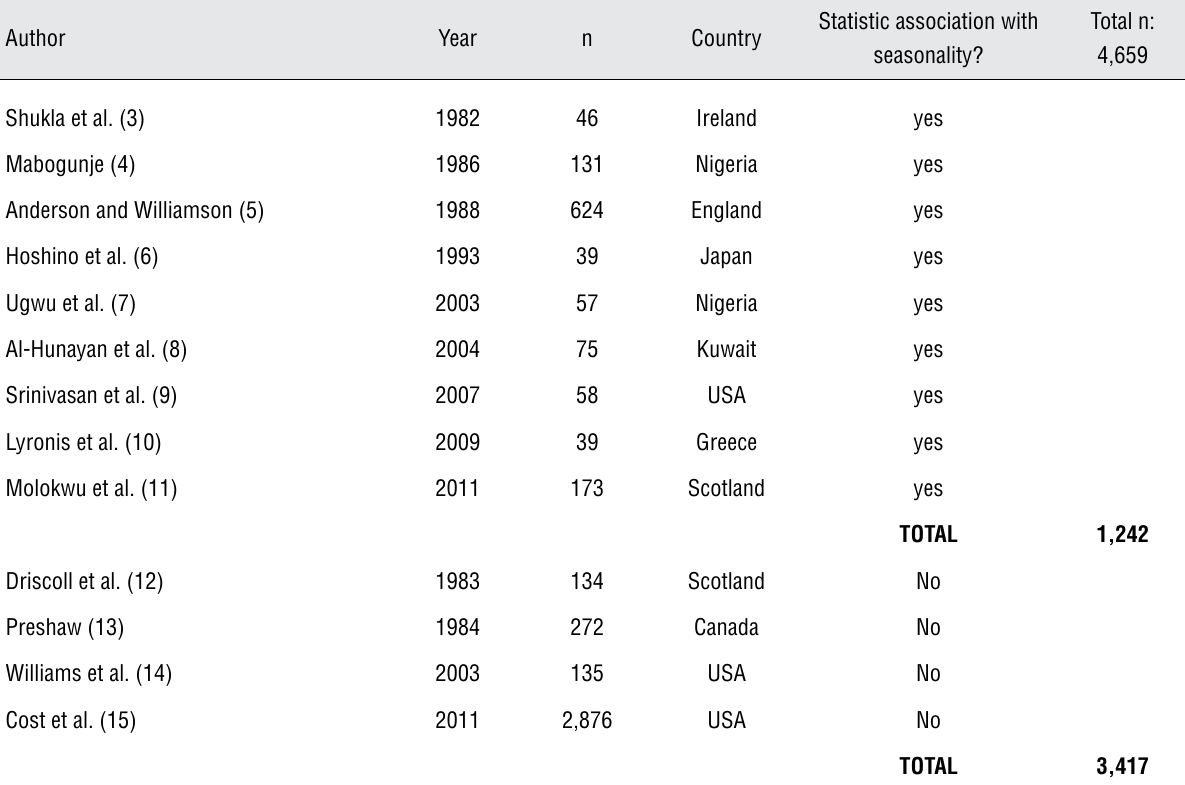
Table 2 - Studies evaluating the association between seasonality and testicular torsion (3-15). Author Year n Country